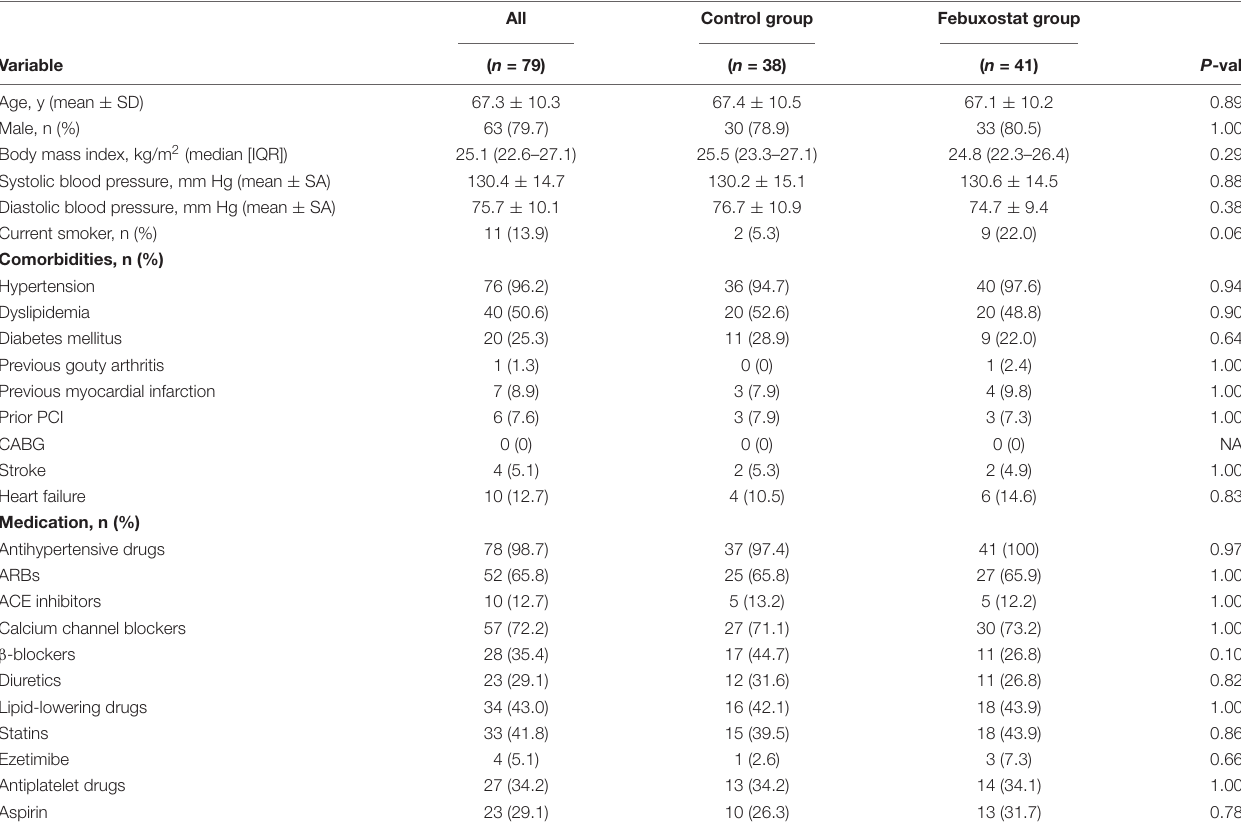
TABLE 1 | Subject clinical characteristics.